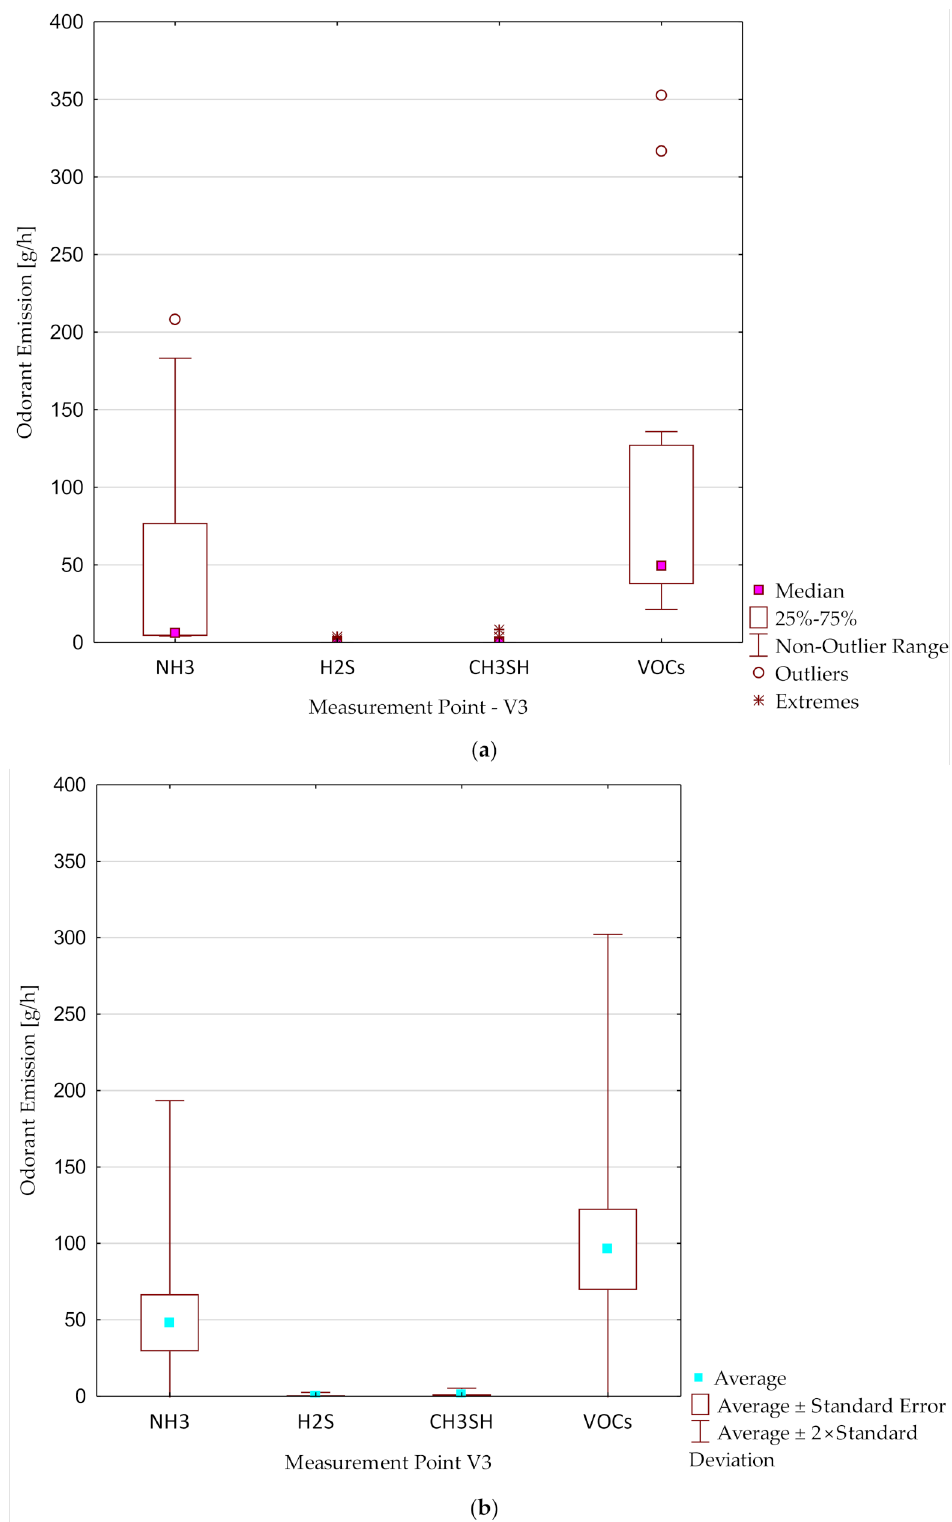
Figure 5. Odorant emission levels with median ( a ) and average ( b ) values at the third point in every measurement